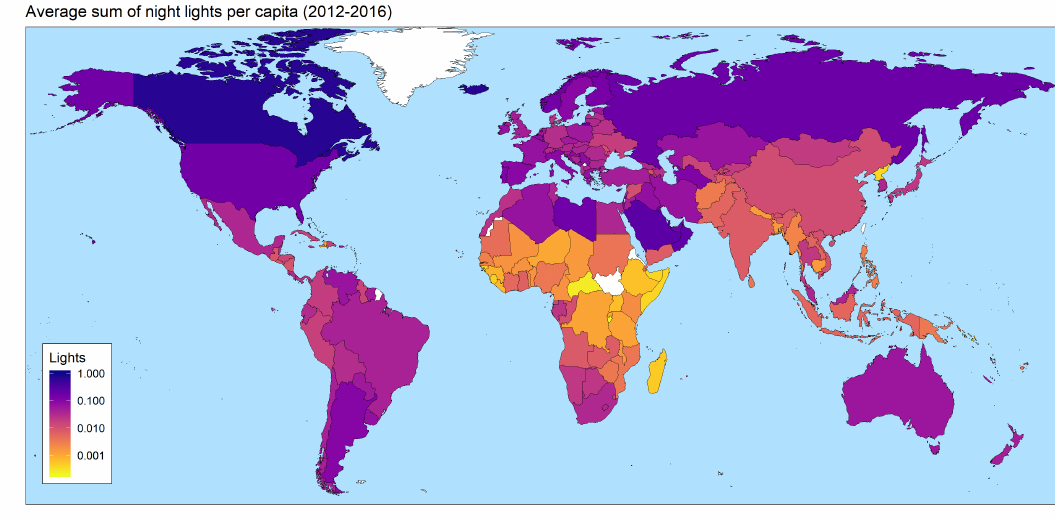
Figure 2. Average annual sum of light per capita,